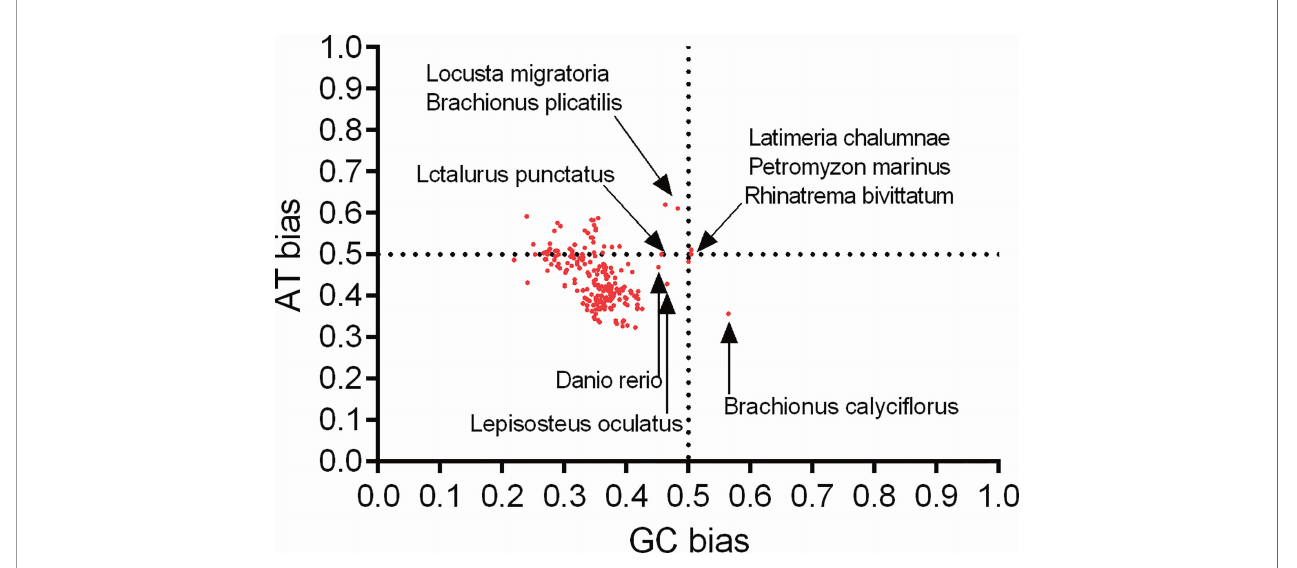
FIGURE 6 | Parity rule 2 bias plot for atg13 genes of 226 eukaryotic